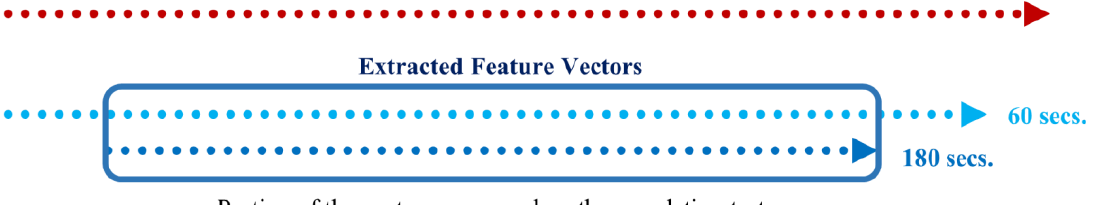
Figure 8. Linear Regressions of the Statistical Percentages obtained for the features LF, HF, LFpeak and LF/HF .